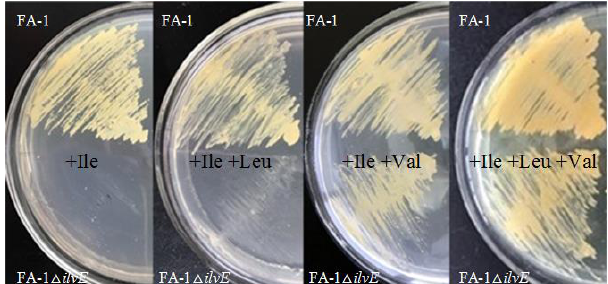
Figure 2. Growth of different C. glutamicum strains on different medium. At the top is shown the C. glutamicum FA-1, and the C. glutamicum FA-1 △ ilvE is shown at the bottom. Growth was carried out on medium CGXIIG containing L -methionine with amino acids supplemented as indicated (each at 0.1